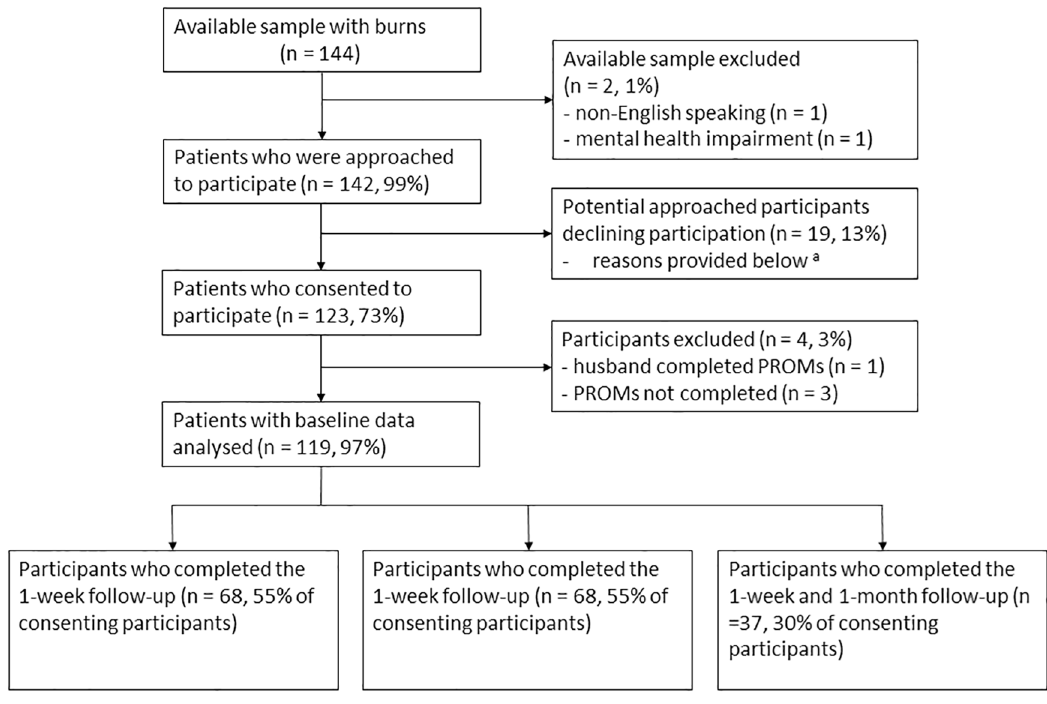
Fig 1. Flowchart of participants included and